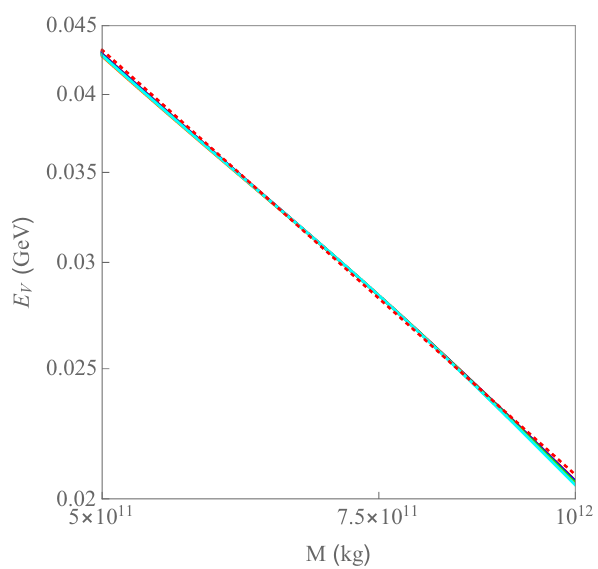
Figure 12 . “Valley” energy as a function of the PBH mass, computed with the semi-analytical method, for ˜ a = 0 , 0 . 1 , 0 . 2 , 0 . 3 , 0 . 5 (red, blue, green, orange and cyan, respectively). The dotted red line yields the best fit curve in eq.